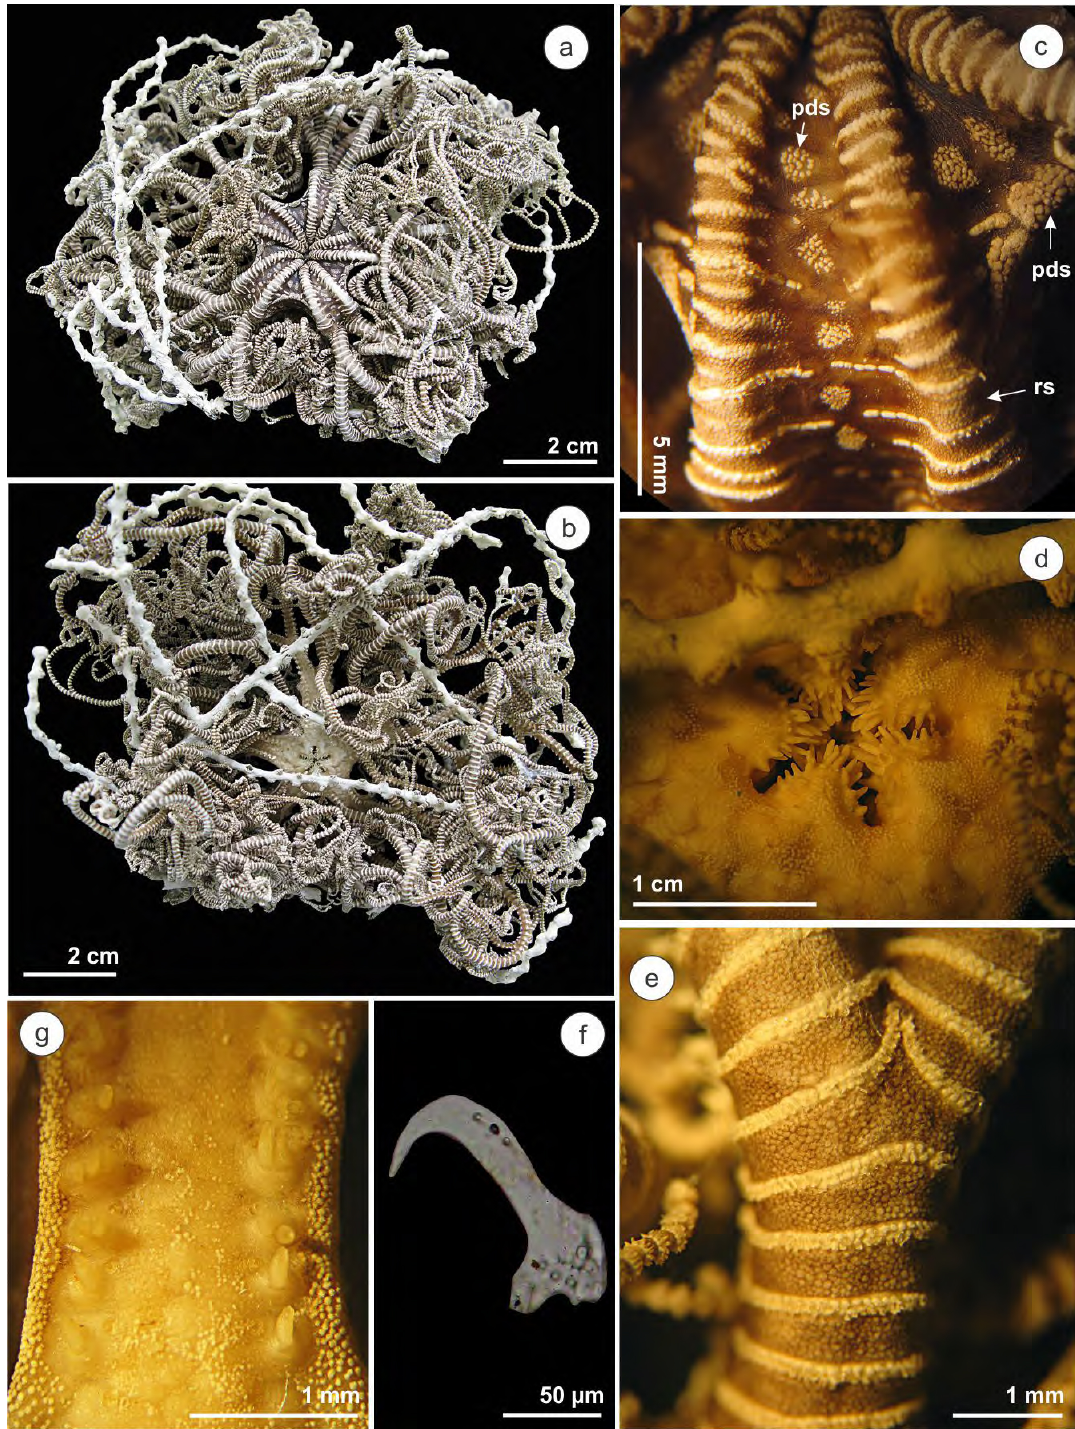
Figure 1. Main taxonomic characters of Astrocyclus caecilia . ( a ) Dorsal view of disk; ( b ) ventral view of disk; ( c ) detail of radial shield; ( d ) detail of jaw; ( e ) dorsal view of arm; ( f ) microscopic hooks (optical microscopic image); (g) ventral view of